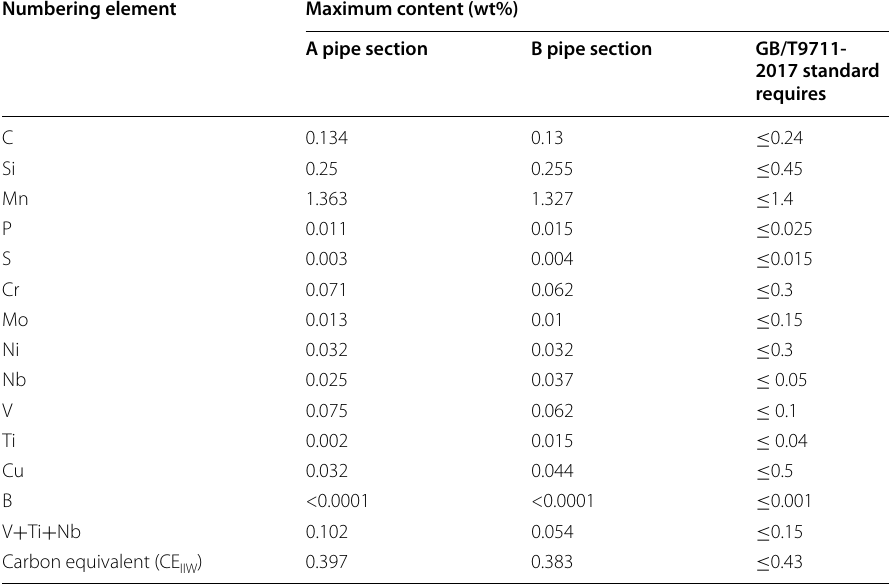
Table 4 Chemical constituents of pipe materials (Wt%)